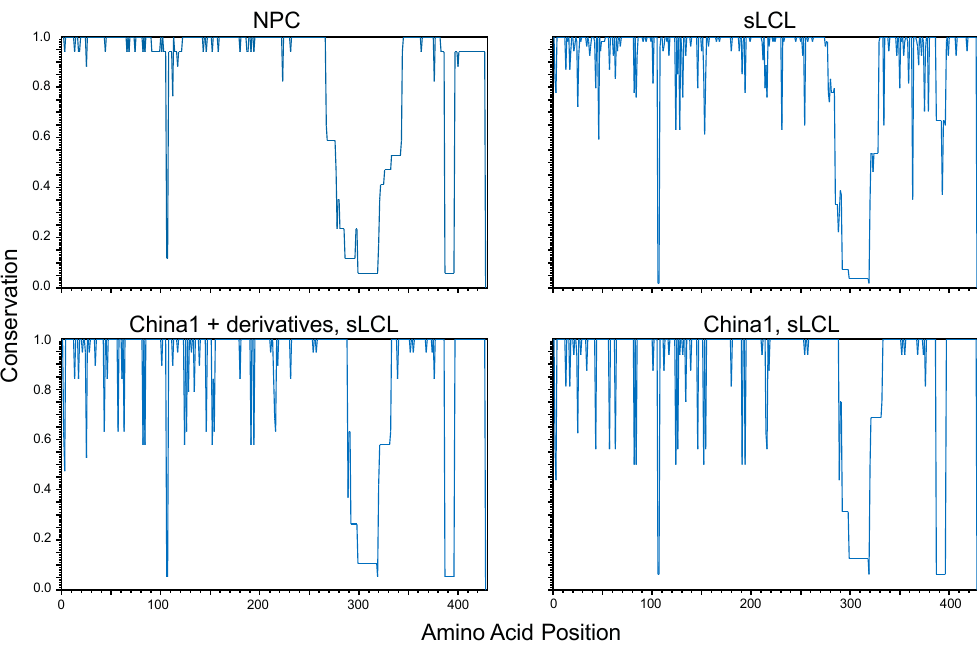
Figure 3. Conservation plots of LMP1 amino acid residues translated from annotated EBV genomes derived from NPC tumors (NPC), spontaneous LCLs (sLCL), and sLCLs typed with China1 LMP1 sequence (China1, sLCL) or, China1 and derivative hybrid sequences (China1 + derivatives, sLCL) [37,90,92,93,96–98]. Conservation plots were generated in CLC Main Workbench 6 and compared to a consensus sequence. A consensus sequence was generated from the combined sequences of NPC and sLCL samples by majority with no gaps and was included in all conservation plots to constrain the number of amino acids to the same total number in all comparisons.